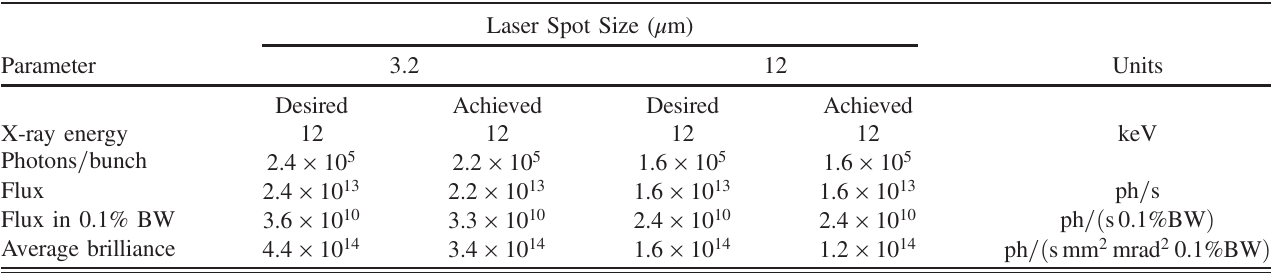
TABLE XIV. Estimated x-ray performance assuming design electron beam attained at IP, compared to desired parameters.